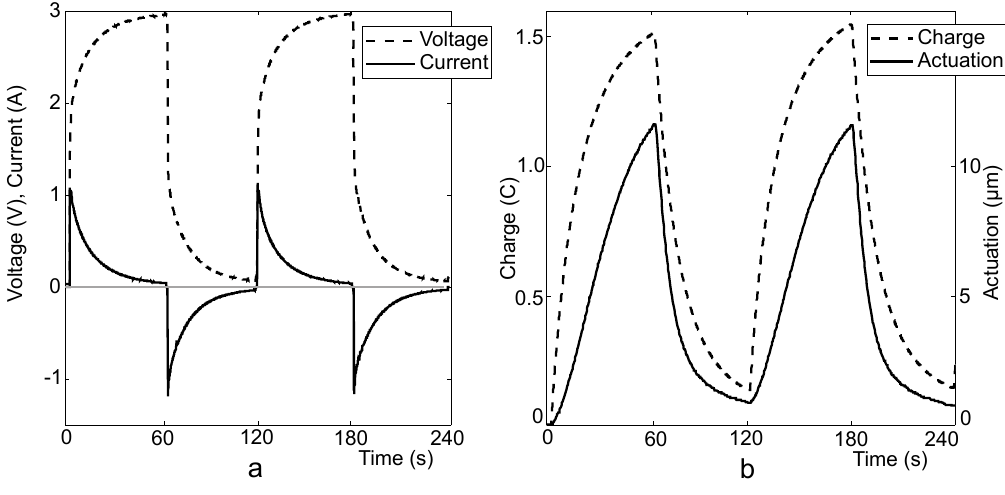
Figure 8. CCCP measurement of EMI800 (I vs . time (a); actuation and charge vs . time